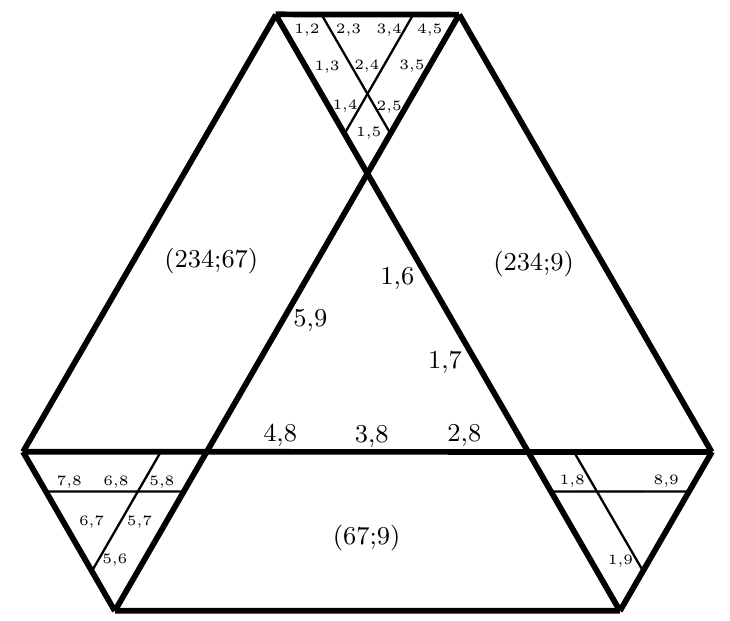
Figure 11 . Schematic partition of the vertices e a + e b (abbreviated by pairs a, b above) of the hypersimplex ∆ 2 , 9 by the split kinematics (1 , 5 , 8) . The projection x 7→ ( x 12345 , x 5678 , x 891 ) from R 9 to R 3 is by construction constant on connected components. The Mandelstam invariants which are set to zero are indicated in the three large